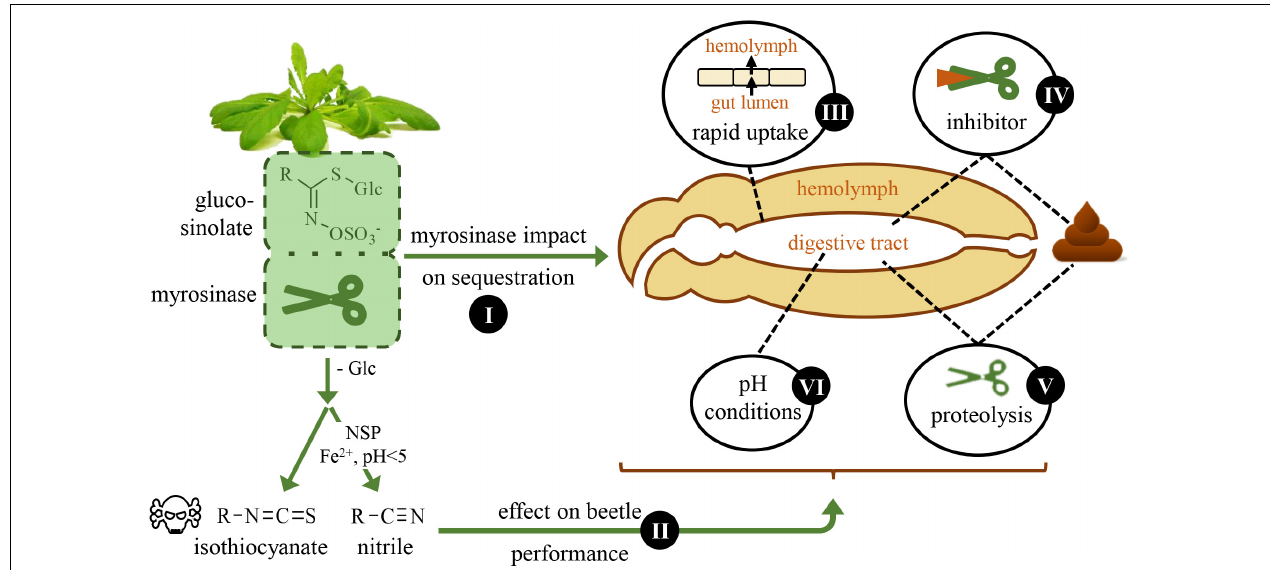
FIGURE 1 | Schematic overview of questions that are addressed in this study. The horseradish flea beetle, Phyllotreta armoraciae , sequesters glucosinolates from its brassicaceous host plants and is thus able to overcome plant myrosinase activity. Here, we investigate the impact of plant myrosinase activity on glucosinolate sequestration (I), and the effect of glucosinolate hydrolysis on beetle weight and energy reserves (II). Further, we analyze possible mechanisms that may facilitate sequestration by influencing plant myrosinase activity: a rapid uptake of ingested glucosinolates from the gut (III), the inhibition (IV) and digestion (V) of plant myrosinases, and gut pH conditions